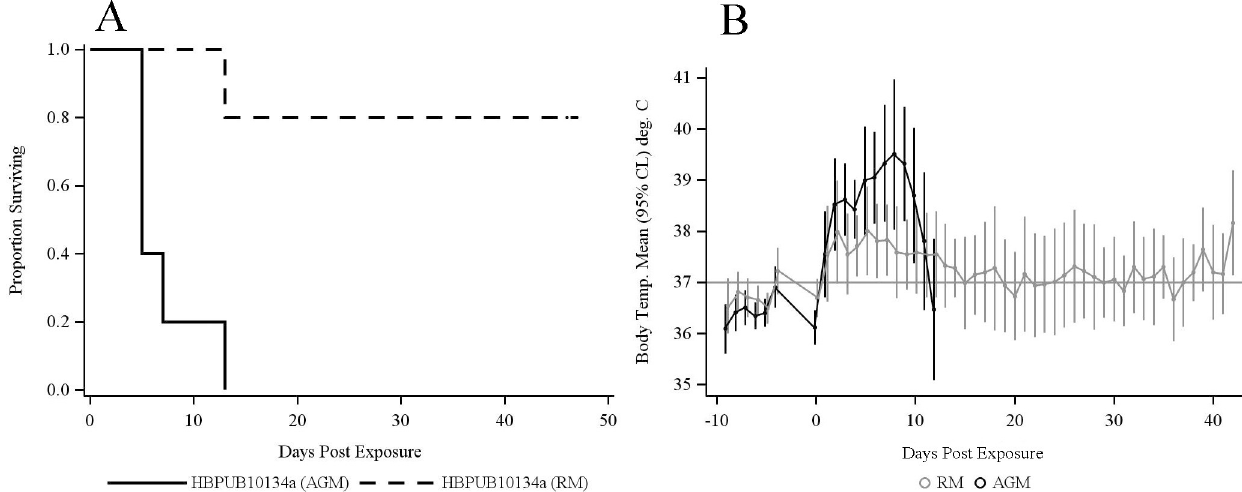
Fig 1. Comparative response of AGMs and RMs challenged with aerosolized B . pseudomallei HBPUB10134a. Five AGMs and five RMs were exposed to an average dose of 351 CFU (range 248–531) of B . pseudomallei HBPUB10134a. (A) There was a significant difference in survival times between AGMs and RMs by log-rank test ( p = 0.0041). (B) Mean body temperatures were significantly higher in AGMs compared to RMs at early time points. Daily average temperature readings for each animal were computed based on telemetry readings taken at 15 minute intervals. Points and error bars indicate the mean and 95% CL reading for each group (n = 5), and were estimated by a repeated measures linear mixed effects ANOVA model. A difference in the overall time course of the two species was inferred from a statistically significant time by species interaction effect ( p < 0.0001).